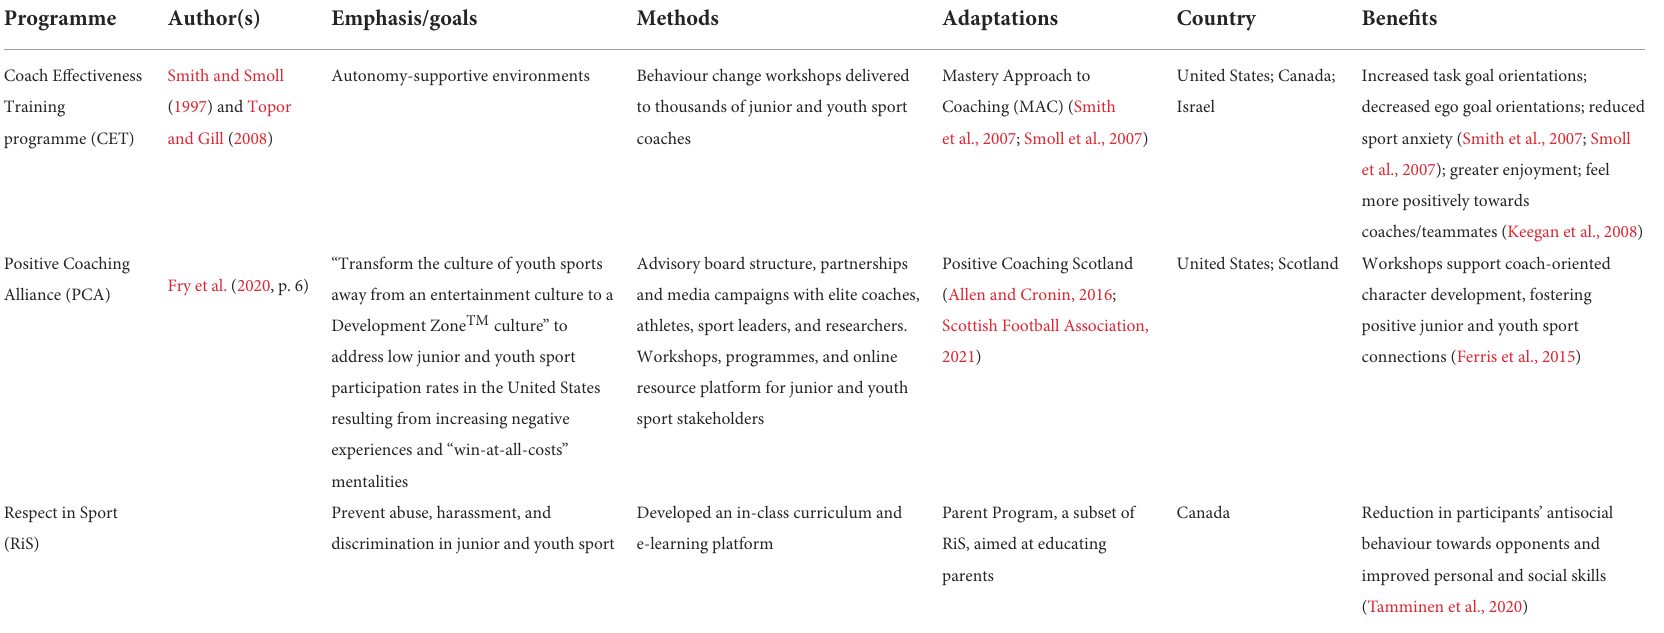
TABLE 1 International coach and parent education